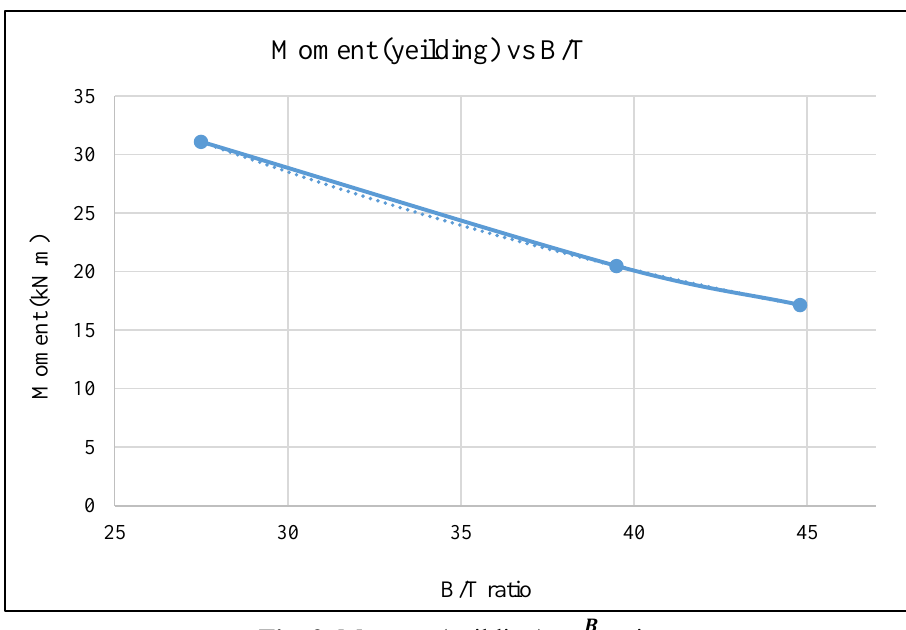
Fig. 9. Moment (yeilding) vs